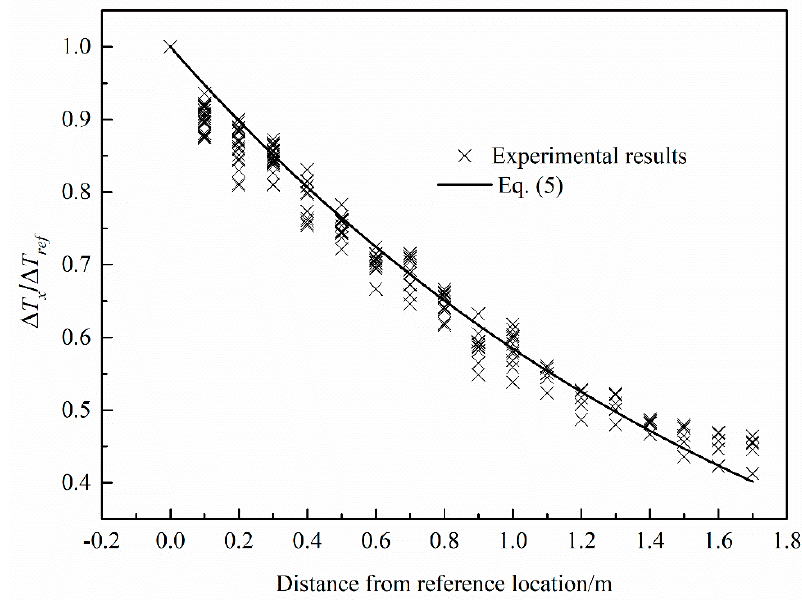
Figure 6. Longitudinal temperature decay in the fire section.